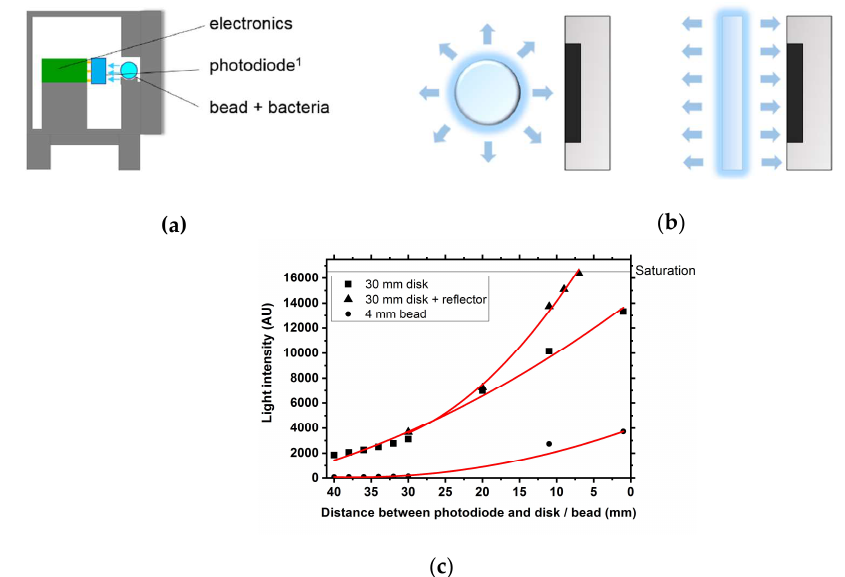
Figure 5. Overview of biosensor prototype 1.0 and its features including an alginate bead